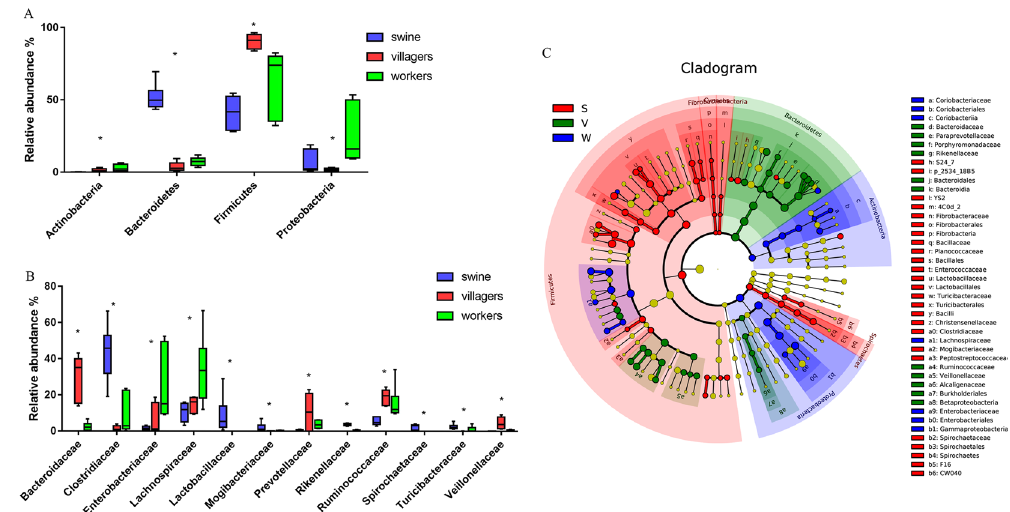
Figure 3. Relative abundance of bacterial composition. Panel (A), microbial phyla. Panel (B), families. * p < 0.05, Kruskal-Wallis test. Only taxa with a mean relative abundance of ≥ 1% are shown. Panel (C). LEfSe among different groups. Small circles with different colors in the diagram represent abundance of those taxa in the respective group. Yellow circles represent non-significant differences in abundance among three different groups of those particular taxa. The brightness of each dot is proportional to its effect